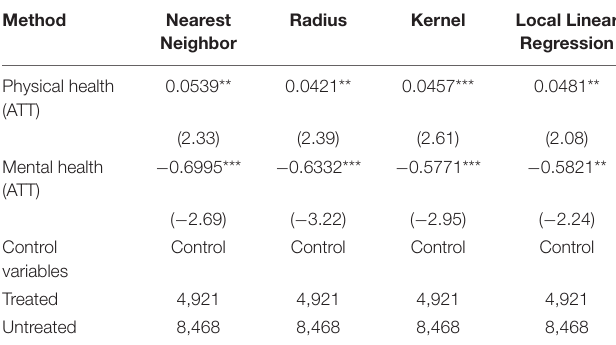
TABLE 3 | Propensity score matching estimation of the effects of adolescent self-control on physical health in adulthood.